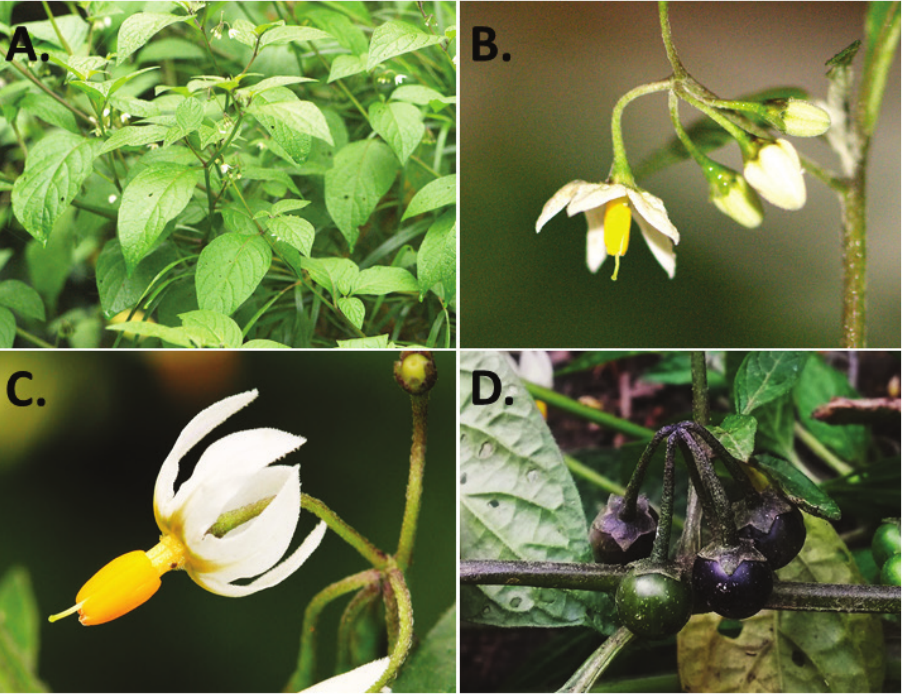
Figure 25. Solanum macrotonum Bitter. A Habit B flowering branch C inflorescence with flowers at full anthesis D mature fruits (all based on Ezedin & Särkinen 48 ). Photos by T.